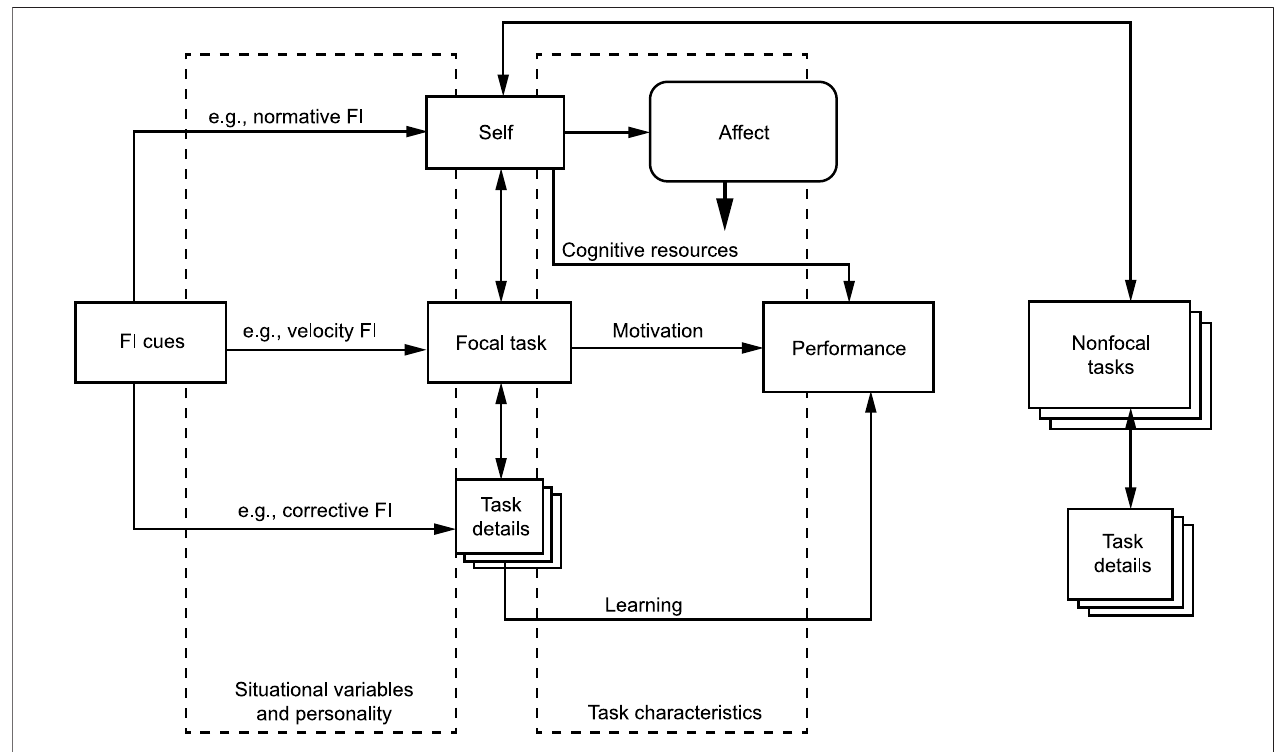
FIGURE 6 | A schematic overview of feedback intervention theory by Kluger and DeNisi